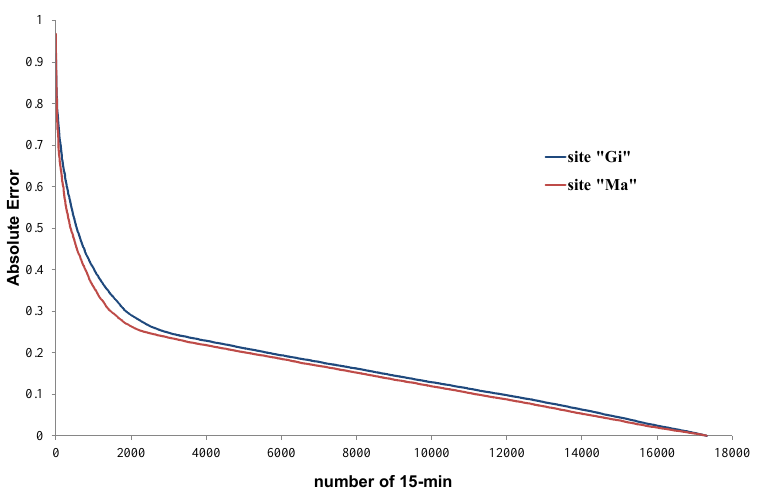
Figure 10. Duration curve of the absolute errors for the solar irradiance estimated data with respect to measurements for the year 2012.